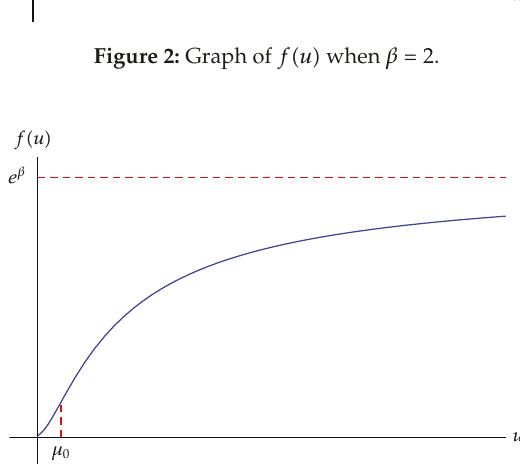
Figure 2: Graph of f (cid:4) u (cid:5) when β (cid:3) 2.